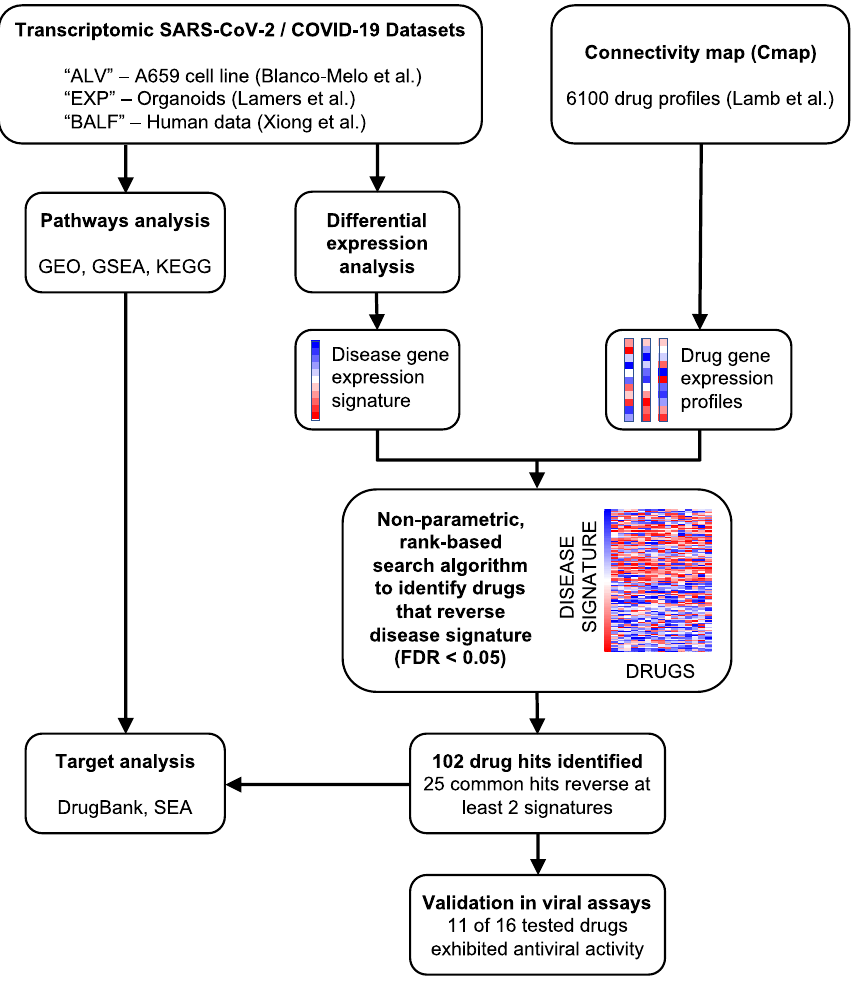
Figure 1. COVID-19 transcriptomics-based bioinformatics approach for drug repositioning. We generated lists of statistically significant differentially expressed genes from the analysis of three published studies of SARS-CoV-2 and COVID-19. The drug repositioning computational pipeline compares the ranked differential expression of the COVID-19 disease signature with that of drug profiles from CMap. A reversal score based on the Kolmogorov–Smirnov statistic is generated for each disease-drug pair. If a drug profile significantly (FDR < 0.05) reverses the disease signature, then the drug could be therapeutic for the disease. Across all datasets, a total of 102 drugs have been identified as potentially therapeutic for COVID-19. Twenty-five drugs were identified in analyses of at least two of the three datasets. We further conducted pathways analyses and targeted analyses on the results, focusing on the 25 shared hits. Finally, we validated 16 of our top predicted hits in live SARS-CoV-2 antiviral